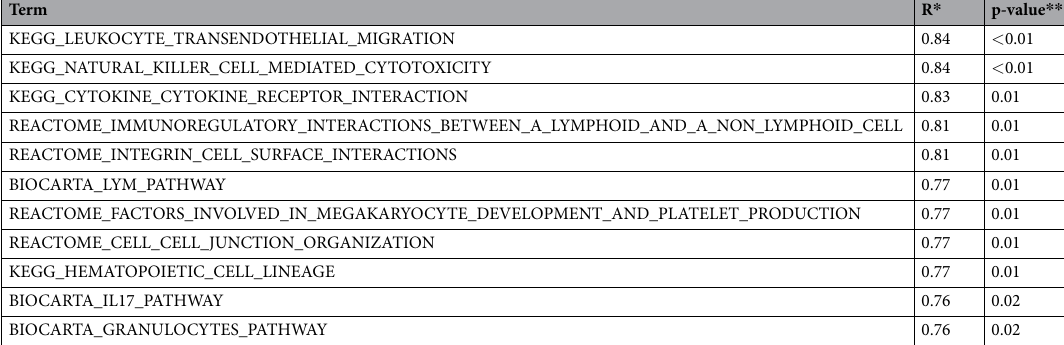
Table 1. The pathway-related gene terms of gene sets with GSVA scores that were highly positively correlated to the ShannonDI in the tumor samples. * R: Spearman correlation coefficient. ** p-value: Spearman correlation